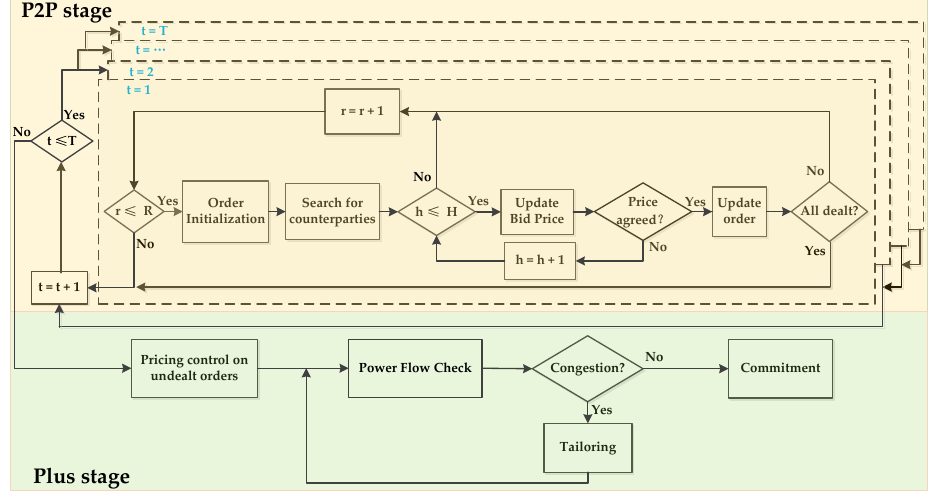
Figure 2. The flowchart of the “P2P Plus” electricity transaction .